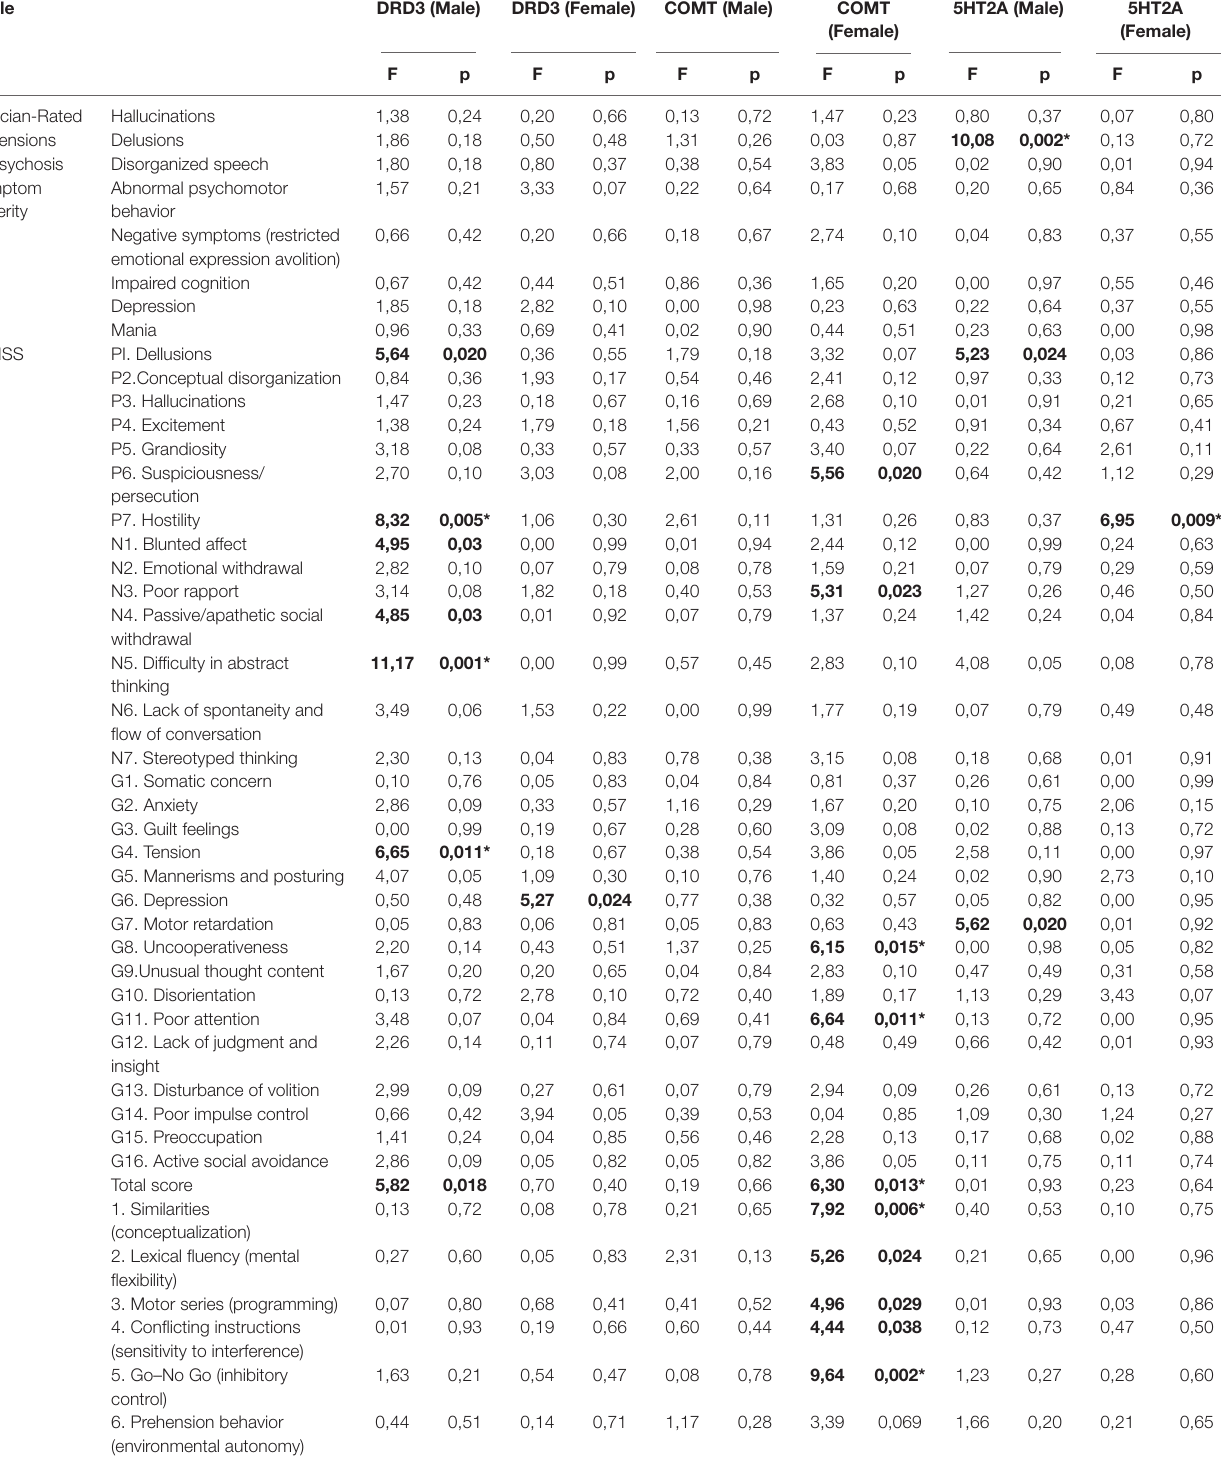
TABLe 4 | The clinical characteristics of the patients across genotypes.